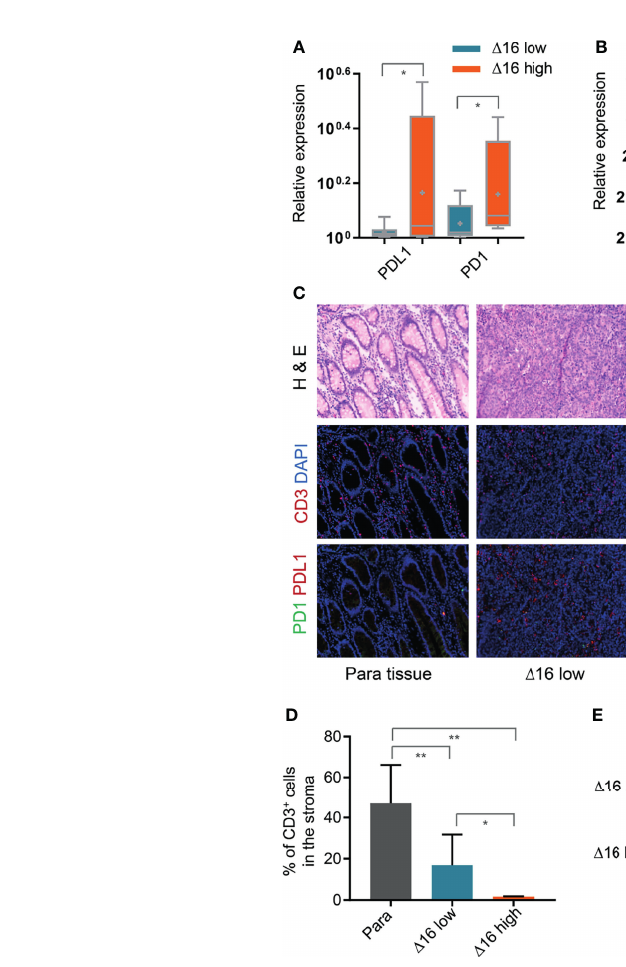
FIGURE 3 | Association of an elevated ERBB2d16/ERBB2 ratio with immunosuppressive microenvironment. (A) Relative mRNA expression levels of PD-L1 and PD- 1 in ERBB2d16 ( D 16) -low (n = 67) and -high (n = 43) groups, respectively. (B) ERBB2d16 expression is positively correlated with those of PD-1 and PD-L1 as determined by Pearson ’ s correlation analysis (n = 110). (C) Hematoxylin and eosin (H&E) and immuno fl uorescent staining (CD3, PD-1 and PD-L1) of tumor tissues and the paired para-carcinoma tissues. Scale bar, 100 m m; (D) The percentage of the CD3-positive cells in the stroma of ERBB2d16-high (n = 20), and -low tumor tissue (n = 20), and the paired para-carcinoma tissue (n = 40), respectively. (E) The percentage of PD-L1-positive tumor cells in ERBB2d16-high (n = 20), and -low tumor tissue (n = 20) tumor tissues, respectively. (*p < 0.05, **p < 0.001, ***p < 0.0001). D 16 low: ERBB2d16/ERBB2 ratio < 0.88; D 16 high: ERBB2d16/ERBB2 ratio ≥ 0.88. ERBB2: human epidermal growth factor receptor-2; ERBB2d16: ERBB2 D Ex16; PD-1: programmed death 1; PD-L1: programmed death ligand 1